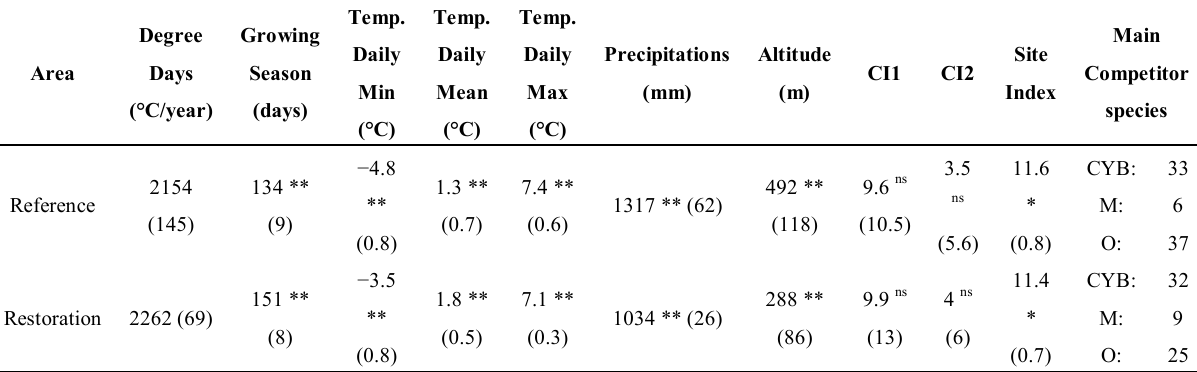
Table 2. Mean characteristics of the variables used as covariates in the study. Standard deviations are given in brackets. ANOVA tests were performed on each variable to assess the equality of population means across both areas. Abbreviations: Temp.: